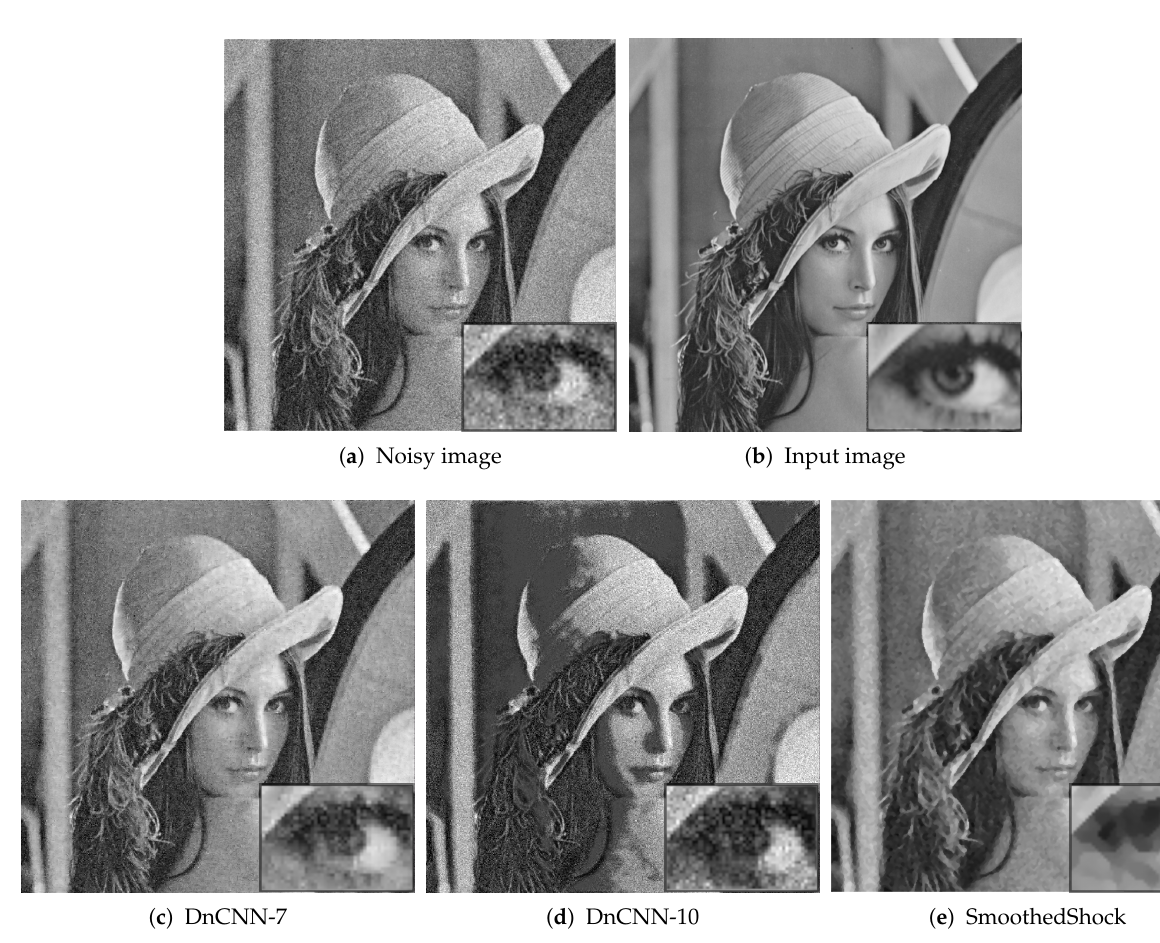
Figure 8. More illustrations of the results obtained for image denoising algorithms of our